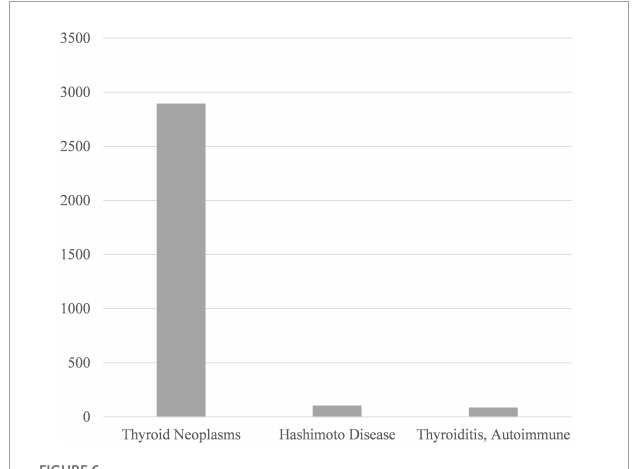
FIGURE6 Comparison between the total amount of Thyroid Neoplasms. Hashimoto Disease, and Autoimmune Thyroiditis.